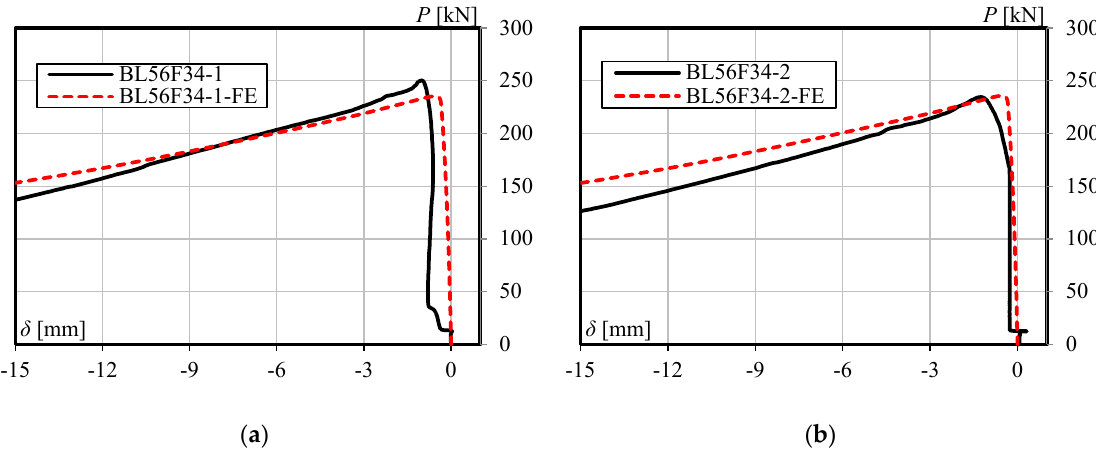
Figure 7. Load versus lateral mid-height deflection response for specimen having a strengthening length of 340 mm: ( a ) BL56F34-1, and ( b )